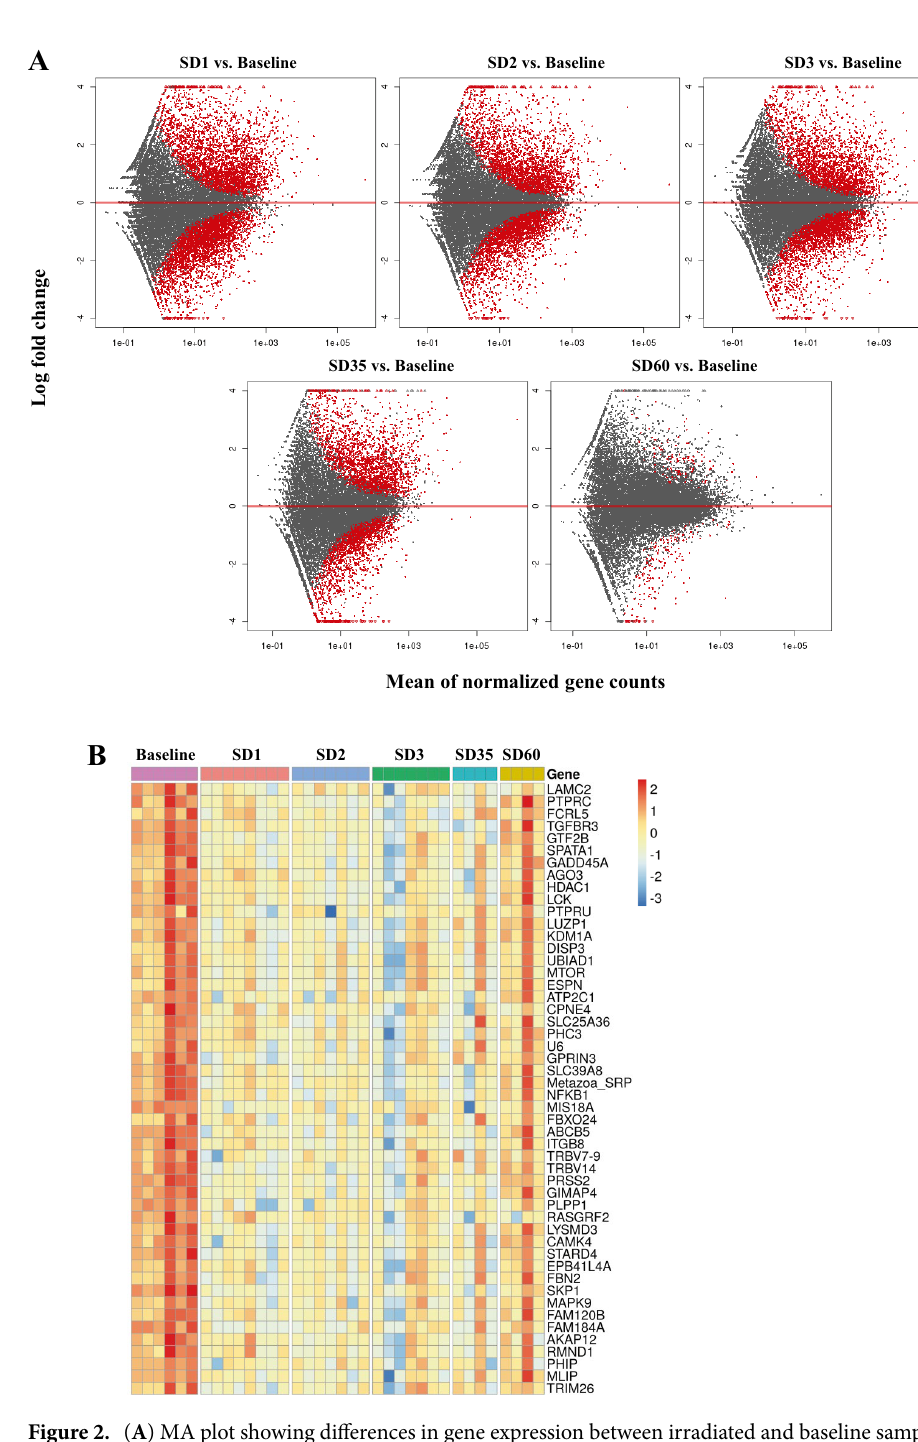
mentary Table S5. For example, in the survivor group, multiple pathways were found to be significantly enriched at SD1, SD2, and SD3 (p value < 0.05). Pertinently, some of these pathways including ephrin receptor signaling, paxillin signaling, CCR3 signaling in eosinophils, ErbB signaling, nitric Oxide signaling in the cardiovascular